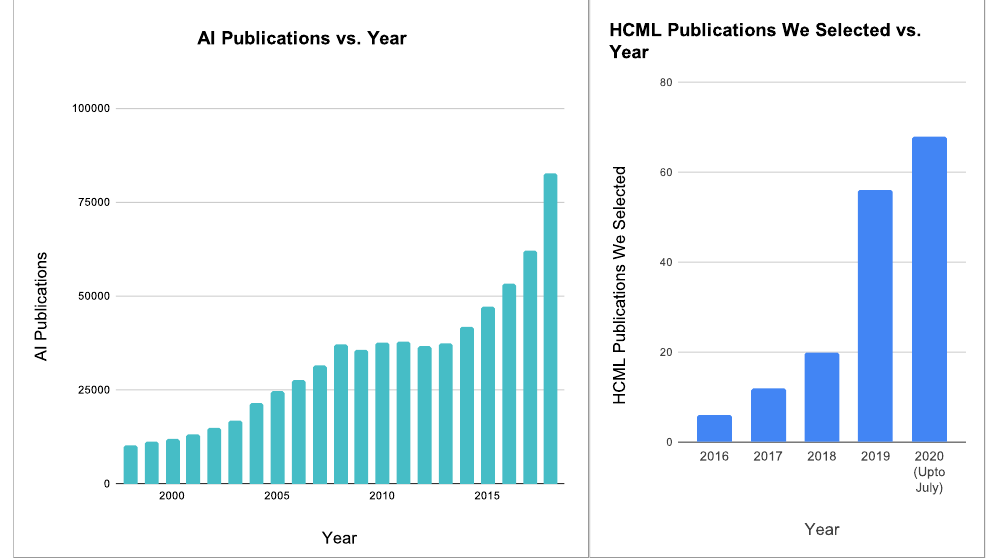
Figure 2. Rise of AI-related publications and Human-Centered Machine Learning (HCML)